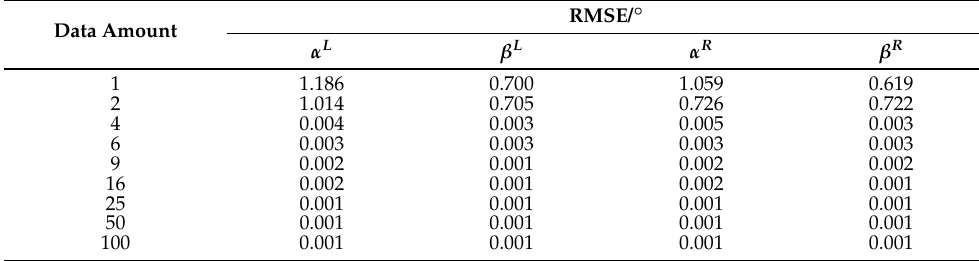
Table 4. Influence of amount of data on kappa-angle